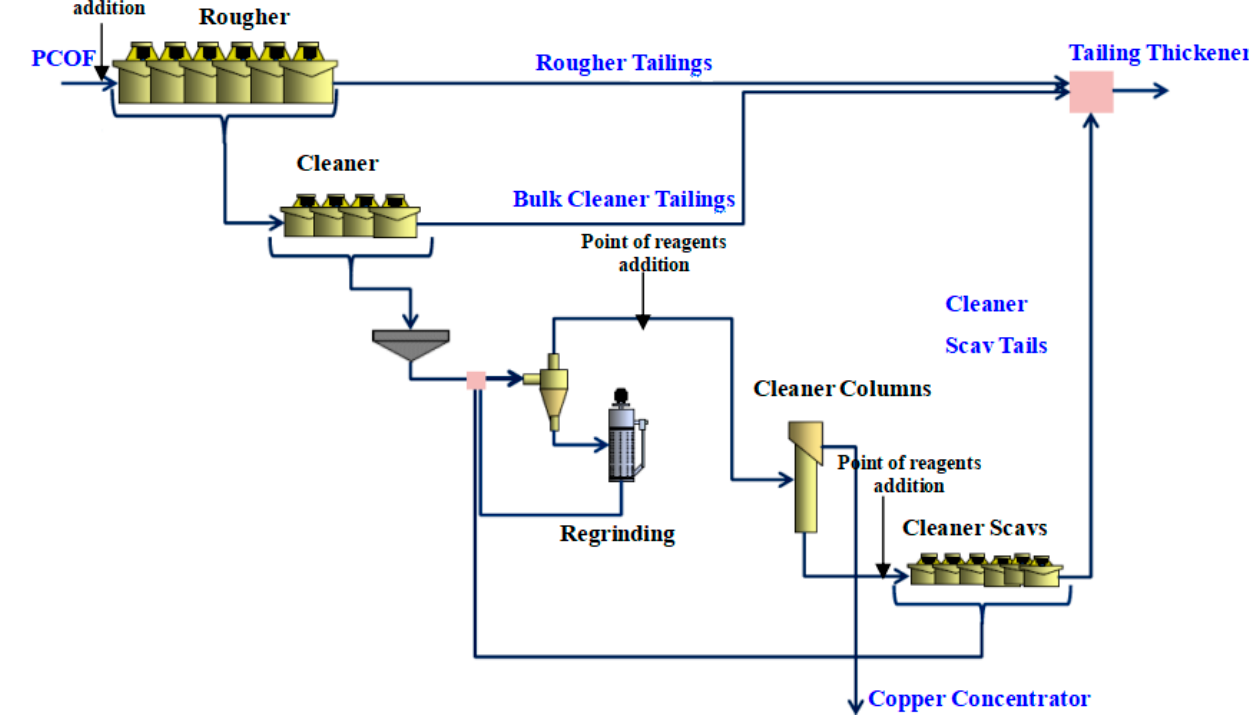
Figure 1. Simplified flotation circuit in the Toromocho expansion plant [1].